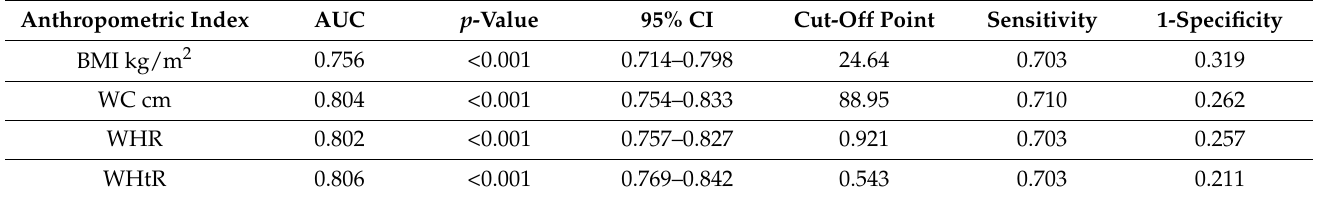
Table 4. Outcomes that show the power of the anthropometric indices to predict diabetes mellitus: the area under the curve, sensitivity, 1-specificity and 95% confidence